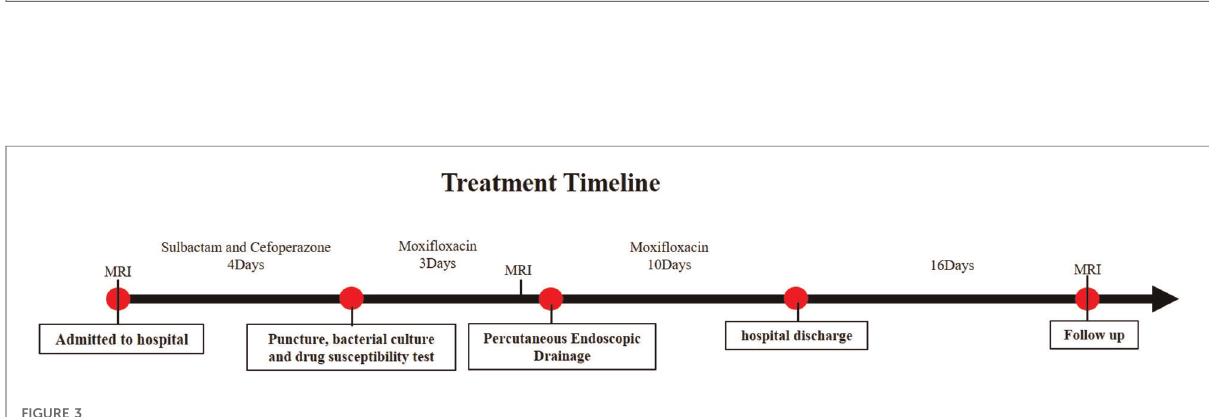
FIGURE 2 Magnetic resonance images of the lumbar before percutaneous endoscopic drainage in axial ( A ) and sagittal ( B ). ( A ) a long segment epidural abscess from L1 to S1 (orange arrow). ( B ) Massive epidural abscesses compressing the spinal cord and nerve roots with paravertebral involvement (orange arrow).